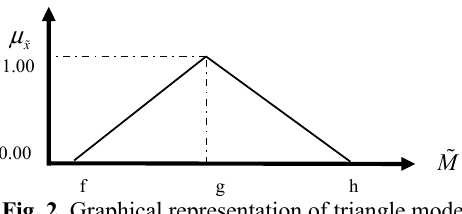
Fig. 2. Graphical representation of triangle